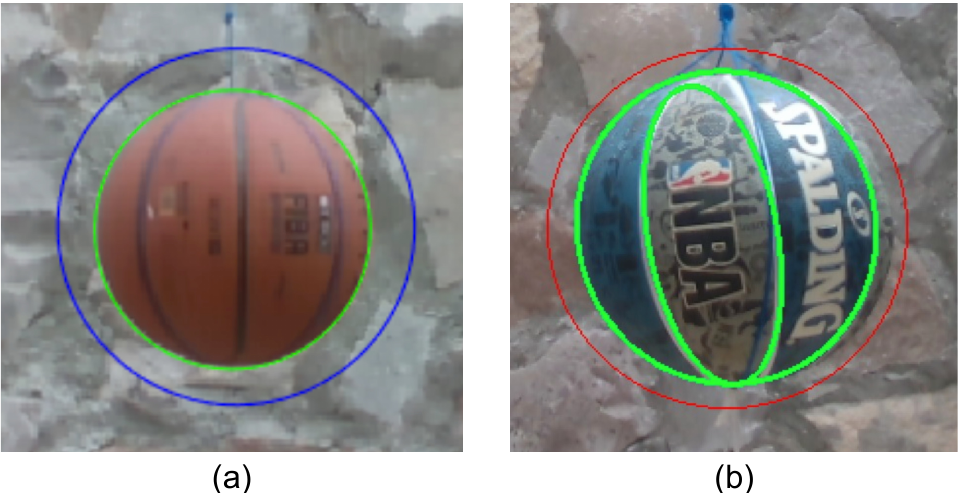
Figure 11. Projection result of the detected sphere using [42] in blue color ( a ); projection result with our proposed method ( b